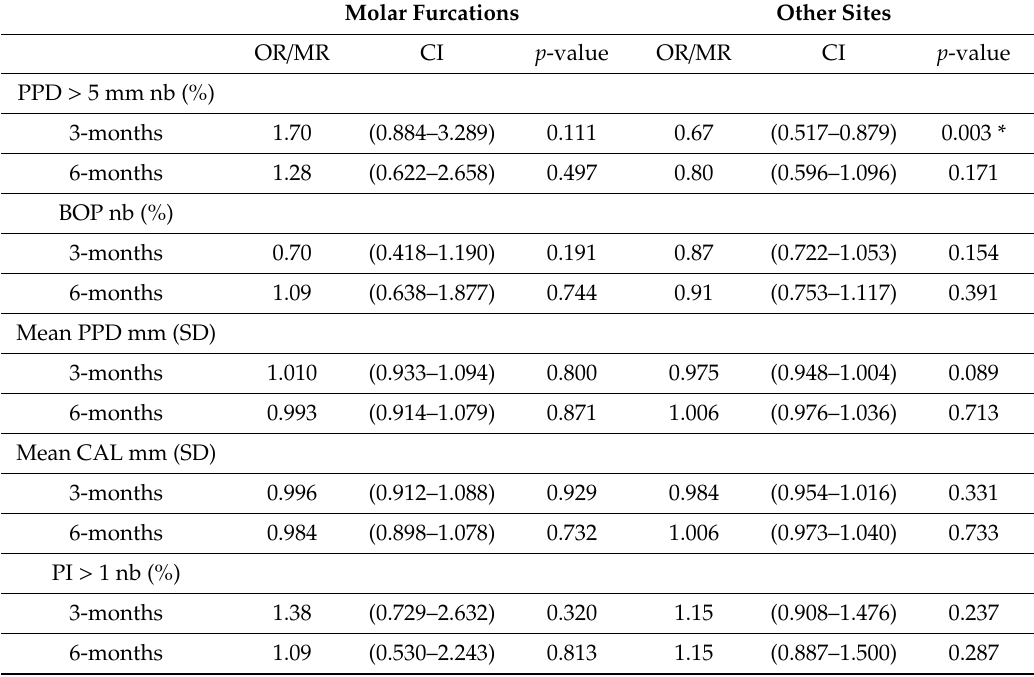
Table 4. Multilevel logistic regression of PDT e ff ect on Pockets > 5 mm, BOP, mean PPD, mean CAL, and PI changes in molar furcation sites and other sites at 3- and 6- months. Molar Furcations Other Sites OR / MR CI p -value OR /